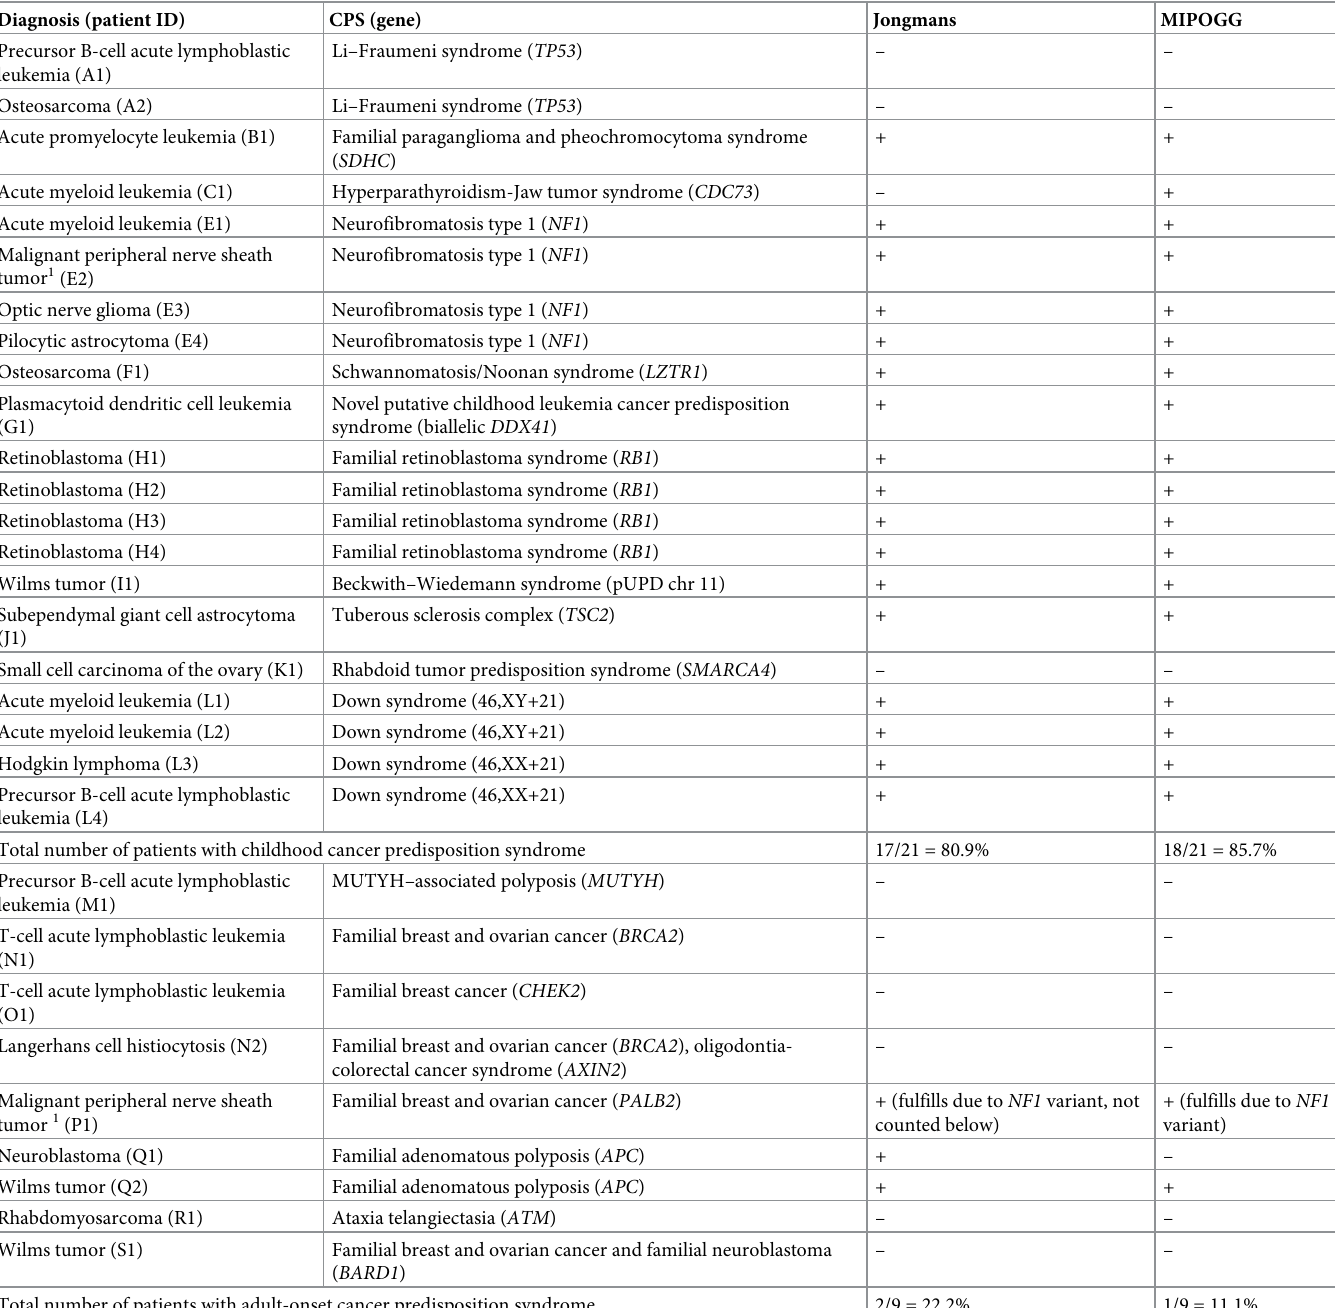
Table 8. Patients with an underlying cancer predisposition syndrome according to Jongmans’ and MIPOGG